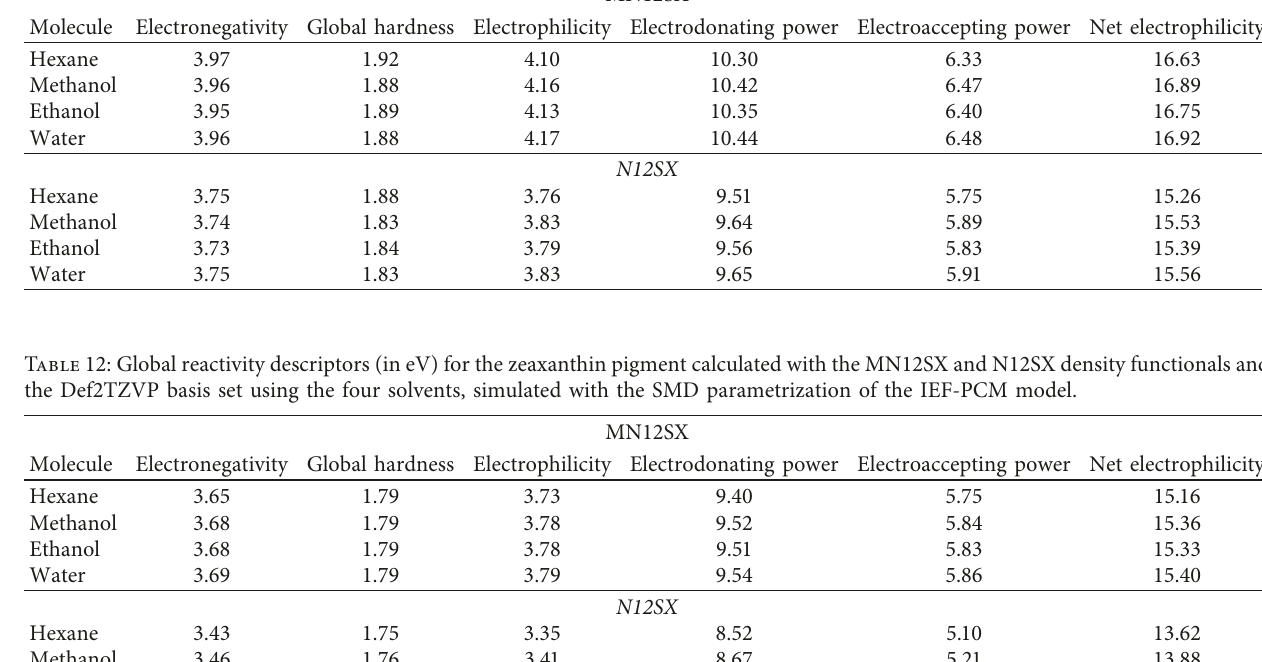
Table 11: Global reactivity descriptors (in eV) for the siphonein pigment calculated with the MN12SX and N12SX density functionals and the Def2TZVP basis set using the four solvents, simulated with the SMD parametrization of the IEF-PCM model.